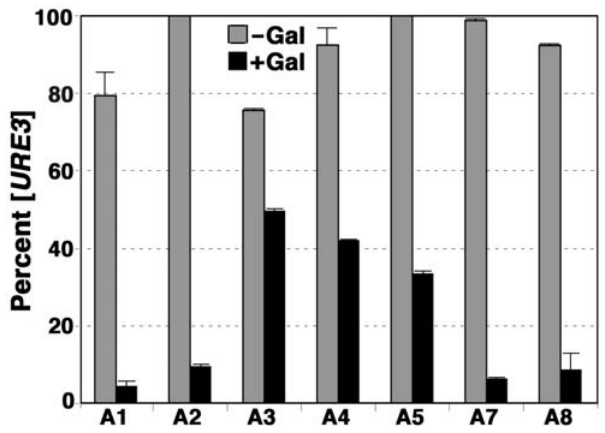
Figure 10. Efficiency of [ URE3 ] curing by elevated Ydj1p depends on Hsp70 isoform. Cultures of 1161 [ URE3 ] strains A1–A8 (except A6, which cannot propagate [ URE3 ]), as indicated, were split into non-inducing (-Gal) and Ydj1p inducing ( + Gal) conditions and grown to OD 600nm =1–2. Aliquots were diluted to obtain 300–500 cells per plate onto 1/2YPD and the percentage of [ URE3 ] cells remaining, scored as white colonies on the 1/2YPD plates, is shown. Data are averages of at least two experiments, error bars indicate standard deviation. For strains A2 and A5 we saw no loss of the prion among a total of about 1500 colonies. Overexpressing Ydj1p had no noticeable effects on fitness of any of the strains.